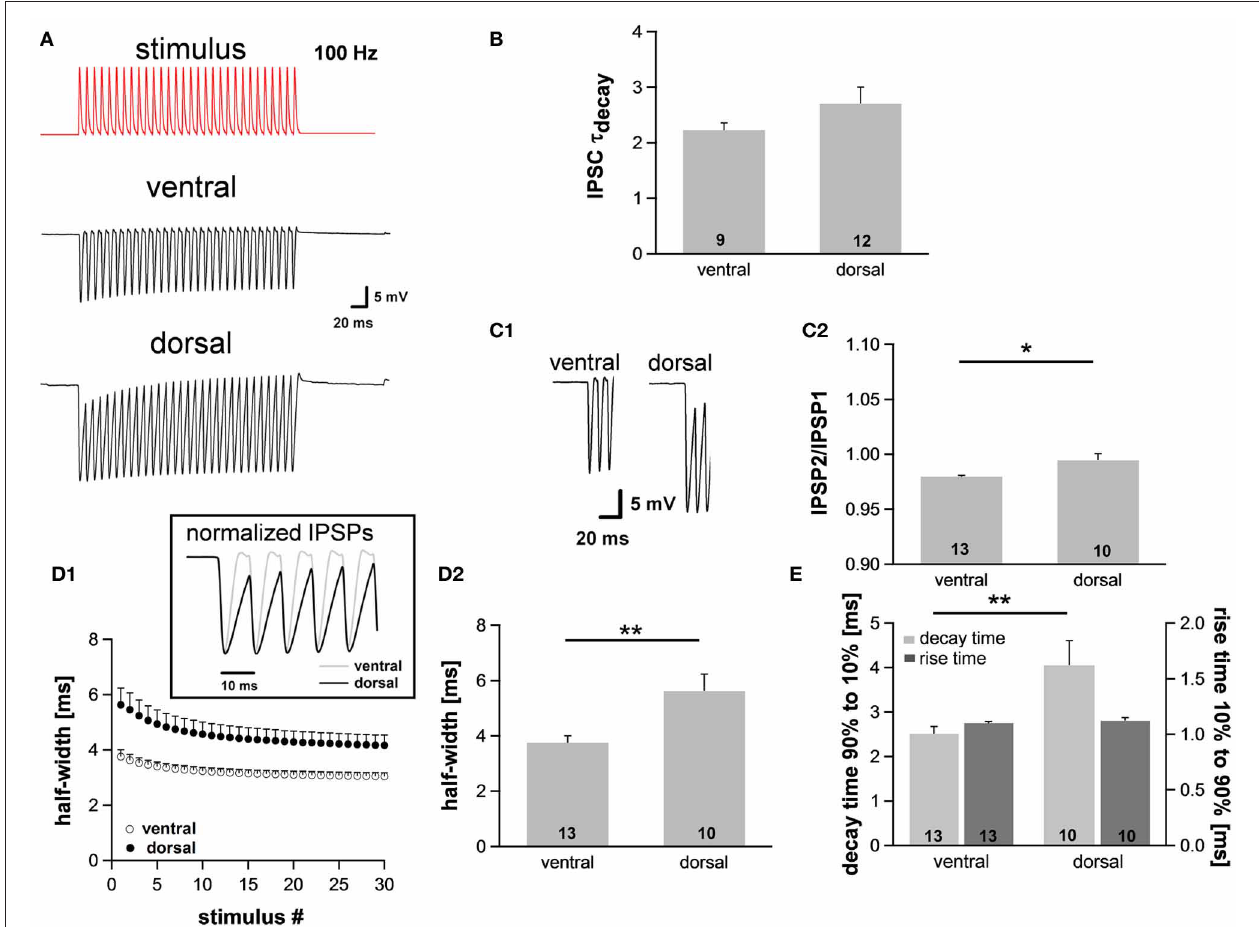
FIGURE 4 | The integration of synaptic inputs varies along the dorsoventral axis. (A) Representative voltage traces to simulated IPSC trains (100Hz). (B) The time course of IPSCs does not vary along the dorsoventral axis as indicated by the decay time. IPSCs were evoked by stimulating the slice medial or lateral the MSO with a stimulation electrode. (C) Dorsal neurons exhibit the largest IPSP amplitude (C1) , and IPSP summation is increased in dorsal neurons (C2) . (D) IPSP time course changes along the dorsoventral axis as depicted in the inset. The